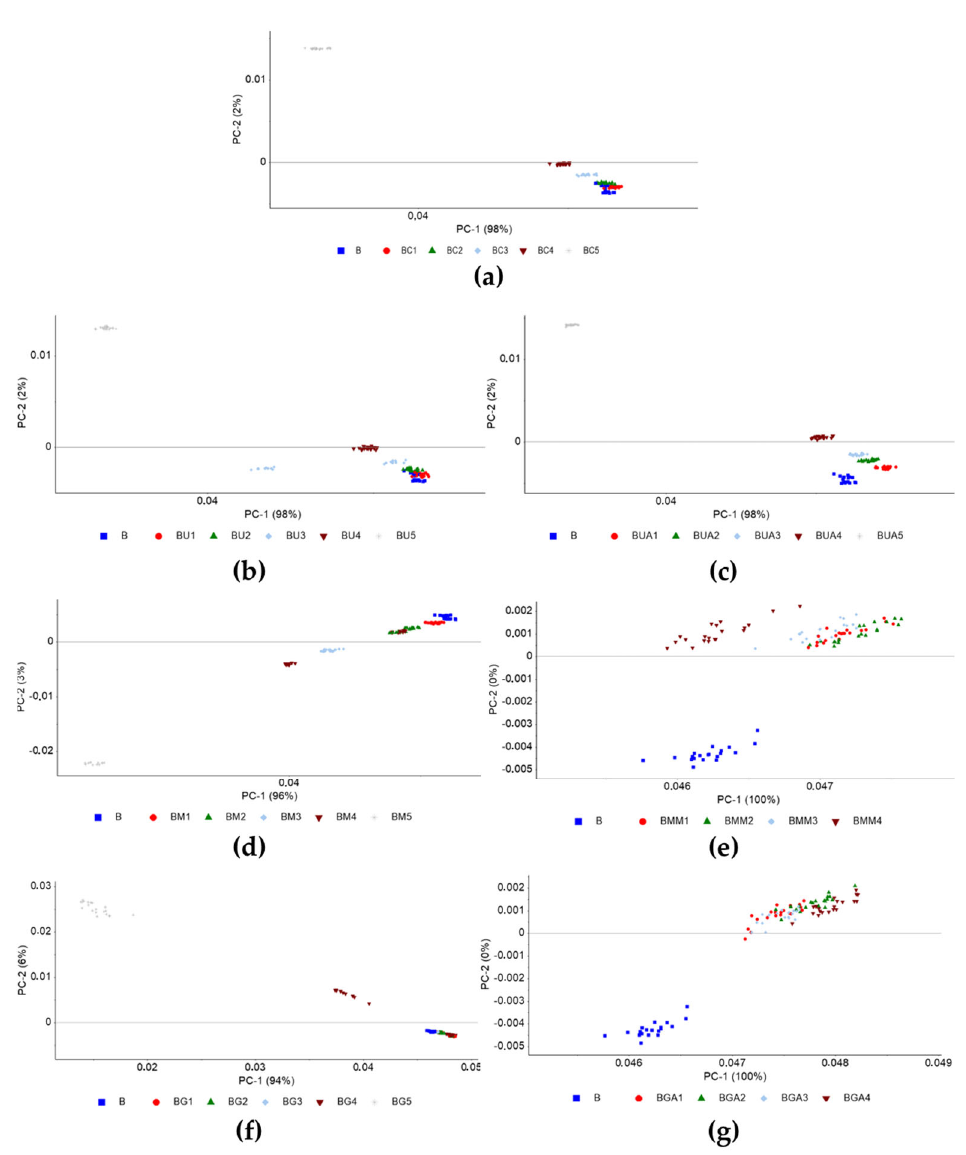
Figure A1 . PCA based on the 2nd order derivative FT-NIR spectra between 4000 and 6800 cm − 1 of pure biodiesel (B) and blends ( a ) BC; ( b ) BU; ( c ) BUA; ( d ) BM; ( e ) BMM; ( f ) BG; ( g ) BGA. Table A1. PLS regression models per blend based on nirU datal data according to the concentration range of each contaminant and the preprocessing